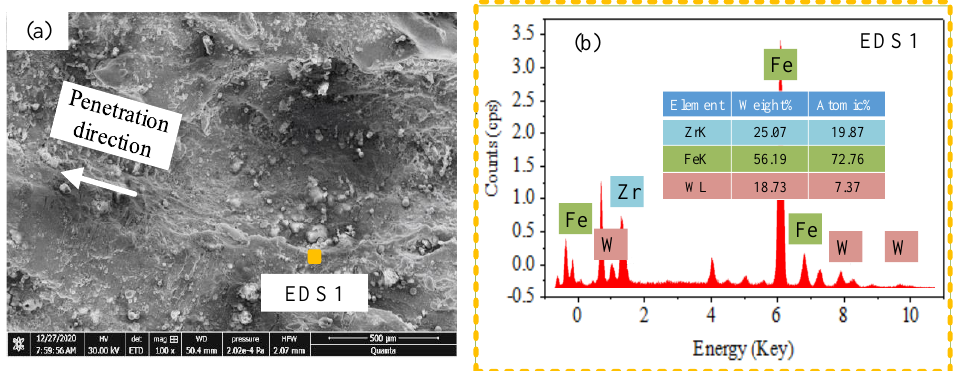
Figure 9. Internal surface morphology and EDS spectra of the crater. ( a ) Region II of Wf/Zr-MG crater and ( b ) EDS 1.